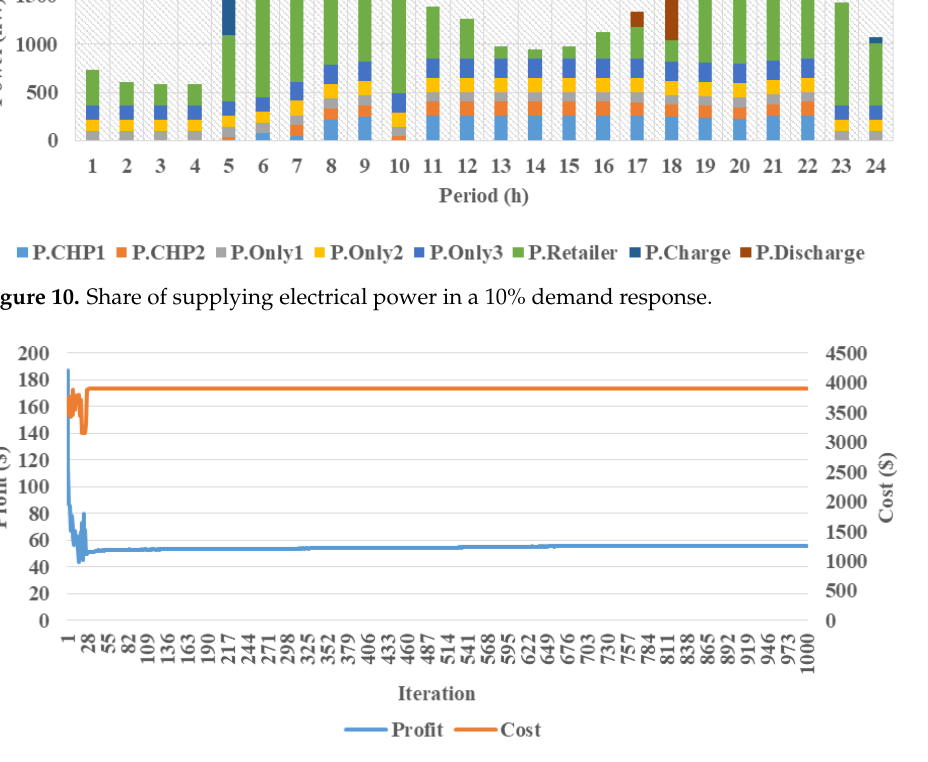
Figure 11. Retailer’s profit and prosumer cost convergence curve in a 10% demand